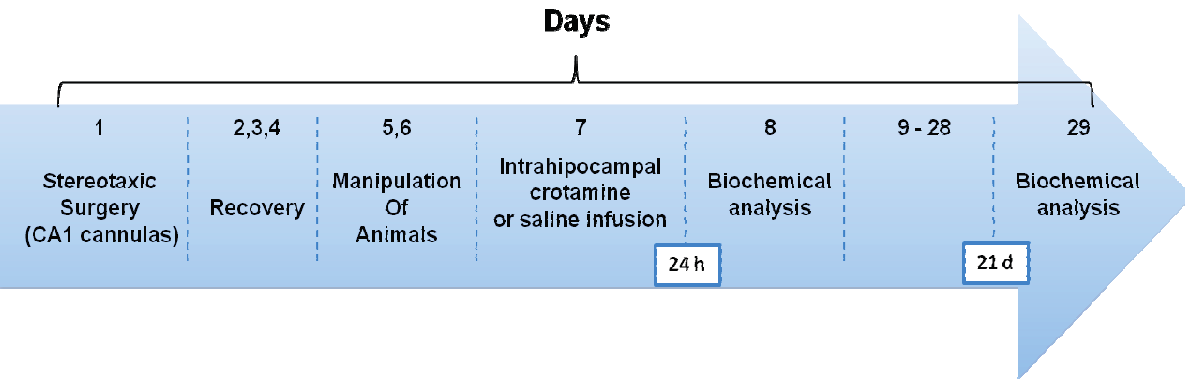
Figure 1. Schematic representation of the experimental procedures. Rats were submitted to a stereotaxic surgery to implant cannulas in the CA1 region of the hippocampus. After 3 days of recovery, they are manipulated for 2 days to adapt to the experimenter. Following the procedures of cannulas’s implantation and recovery the rats in the saline-group received an intrahippocampal infusion of 1 µL/side of vehicle (saline), and rats in the crotamine-group 1 µL/side of crotamine (1 µg/µL). Afterward, six animals from each group were